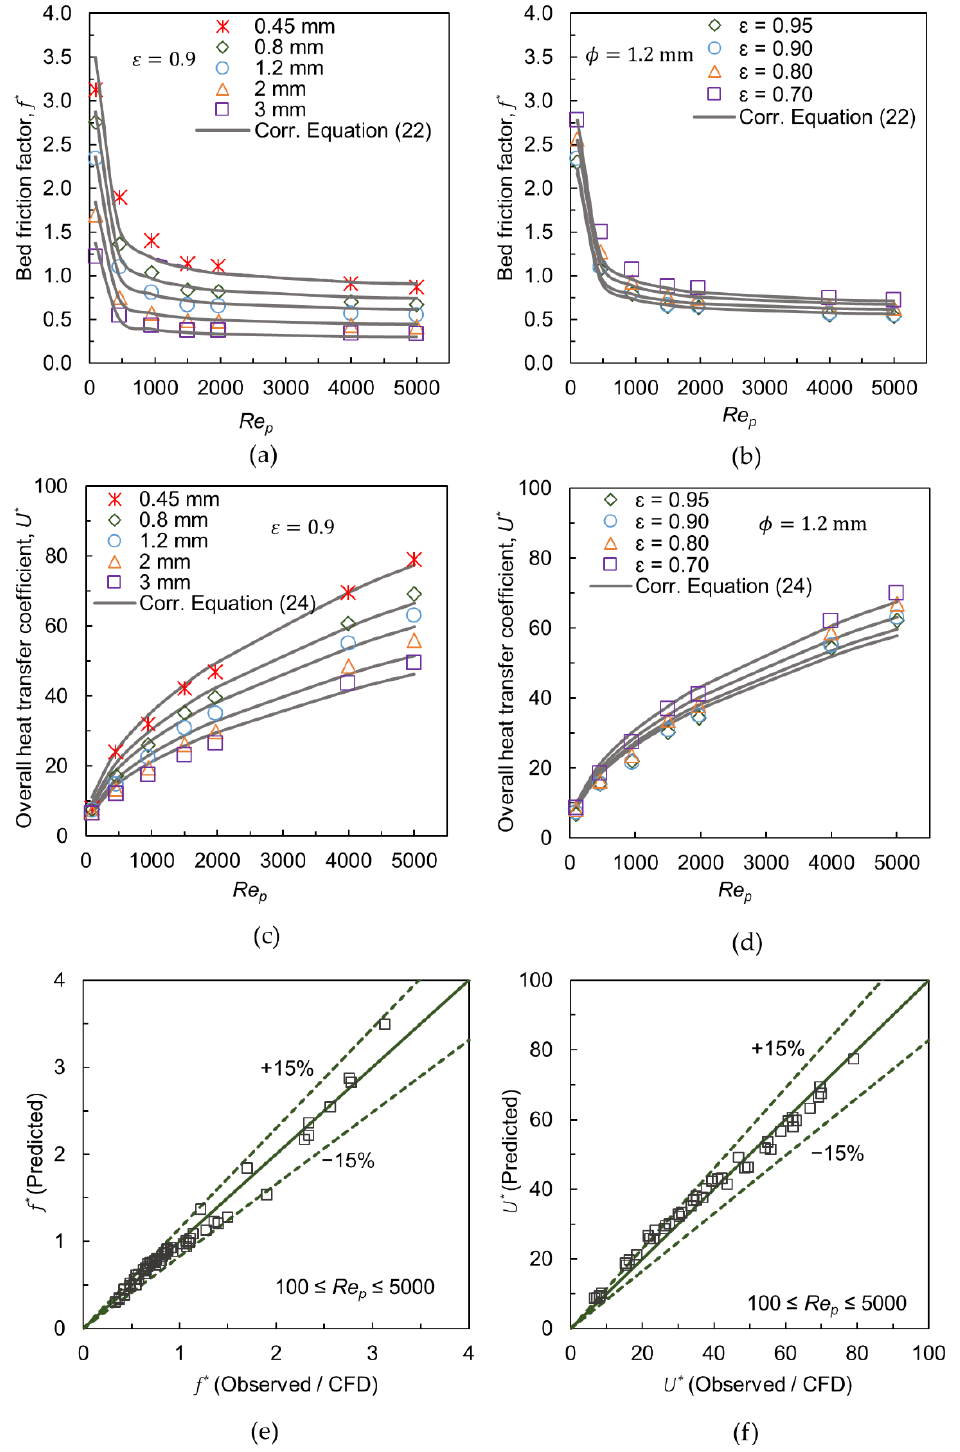
Figure 9. ( a , b ) Comparison of friction factors with correlation Equation (22) for different cell sizes and porosities, respectively; ( c , d ) Comparison of overall heat transfer coefficients with correlation Equation (24) for different cell sizes and porosities, respectively; ( e , f ) Parity plots for friction factor and overall heat transfer coefficient, respectively.